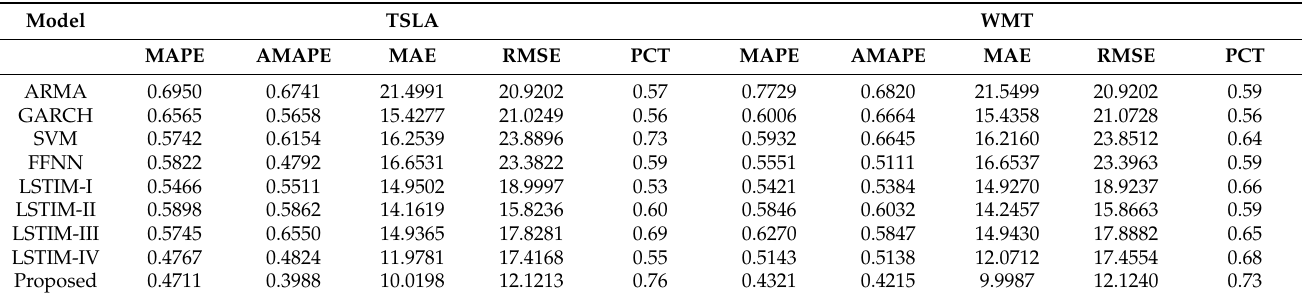
Table 12. Prediction performance for 150 days: TSLA and WMT.